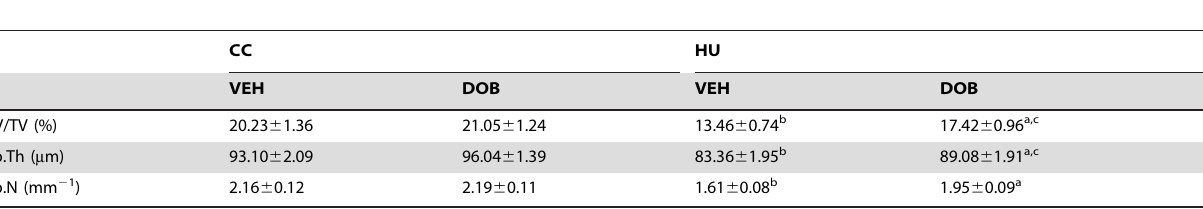
Table 1. Effects of dobutamine (DOB) or vehicle (VEH) administration during hindlimb unloading (HU) or ambulatory cage activity (CC) on distal femur cancellous bone microarchitecture and structure as measured by ex vivo microCT